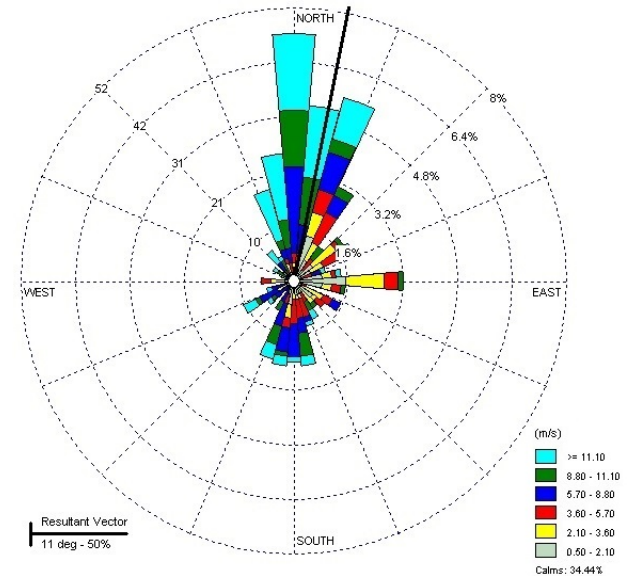
Figure 3. Wind rose in Palu City.